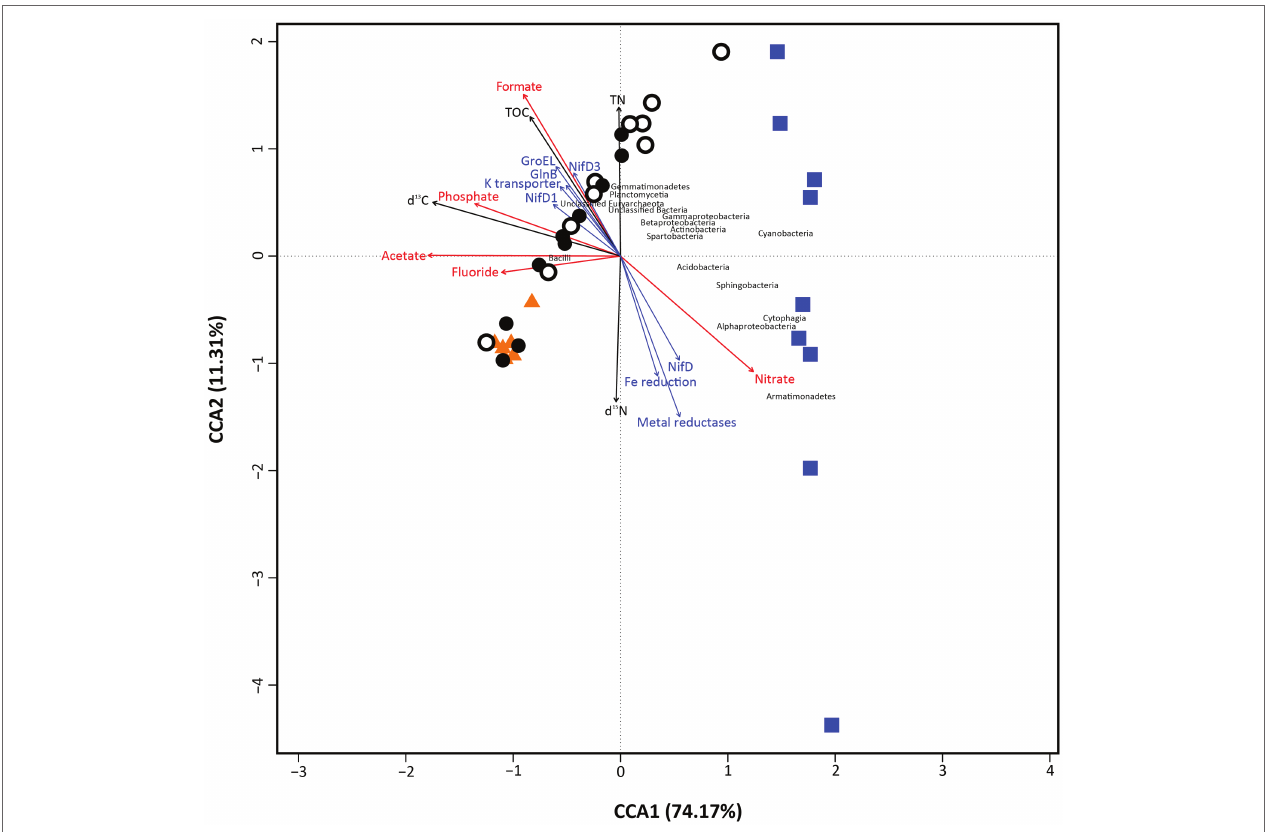
FIGURE 6 | Canonical correspondence analysis (CCA) plot, showing the correspondence of main environmental factors (red arrows represent ion chromatography data) and biomarkers detection (Black arrows depict ‘bulk isotope’ data; blue arrows depict ‘LDChip’ data for microbial metabolism) with the microbial community composition of the samples (Orange triangles depict ‘Bedrock’ samples; white dots depict ‘Surface soil’ samples; black dots depict ‘10 cm-depth’ samples; and blue squares depict ‘Loose rock’ samples. microbial classes appear in black font). The analysis showed 85.48% (CCA1=74.17%, CCA2=11.31%) of total variance of the data and was significant overall at p < 0.05 (999 permutations test for